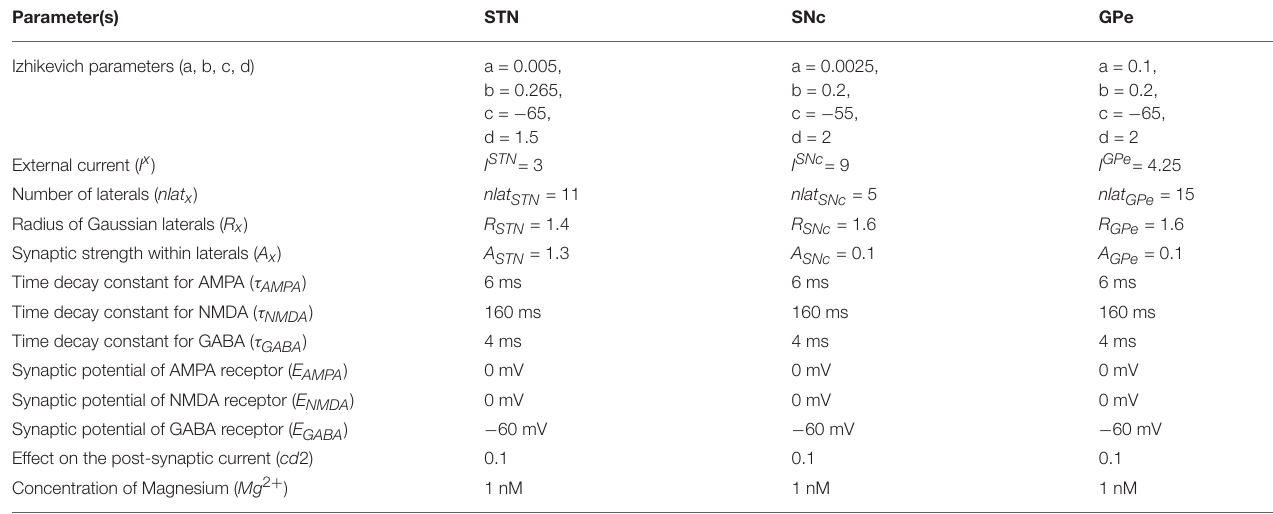
TABLE 1 | Parameter values used in the proposed model. Parameter(s) STN SNc GPe Izhikevich parameters (a, b, c,